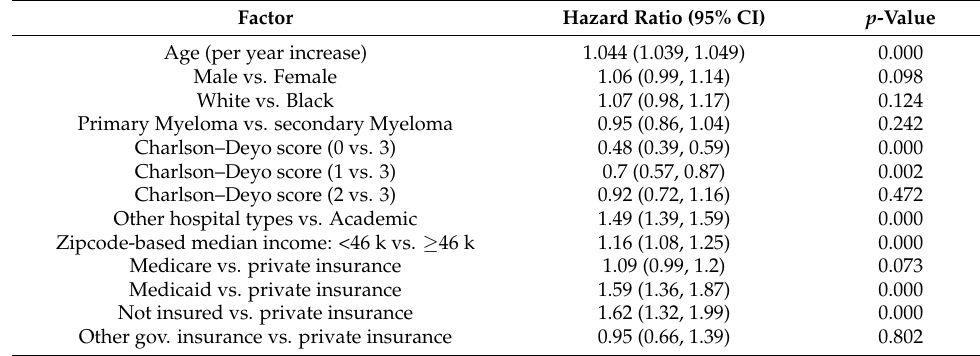
Figure 3. Kaplan–Meier estimation of overall survival comparing patients living in areas with different median household incomes. Higher median income was associated with longer survival after a diagnosis of multiple myeloma. Kaplan–Meier estimation of overall survival as a function of median (zip-code-based) income ( A ); among patients in the higher median income bracket, patients insured by Medicare had worse survival than those with private insurance ( B , C ); this effect was seen in the subgroup of patients <65 years old ( B ), and in the cohort of patients ≥ 65 years old. Table 2. Multivariate Cox regression analysis (all